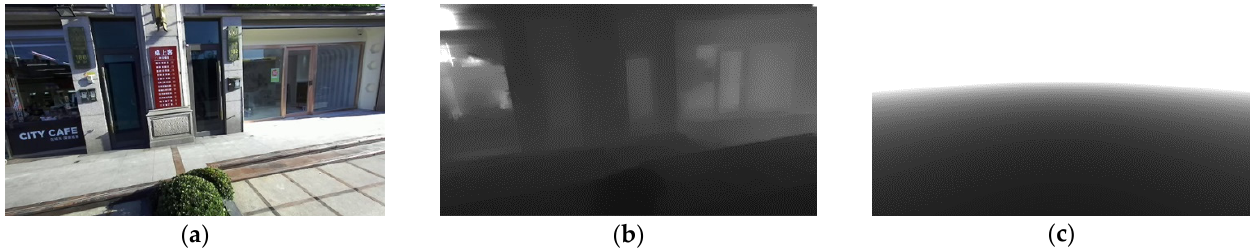
Figure 4. ( a ) The original image; ( b ) the real depth map corresponding to the image in ( a ); ( c ) the depth map of a completely open area.